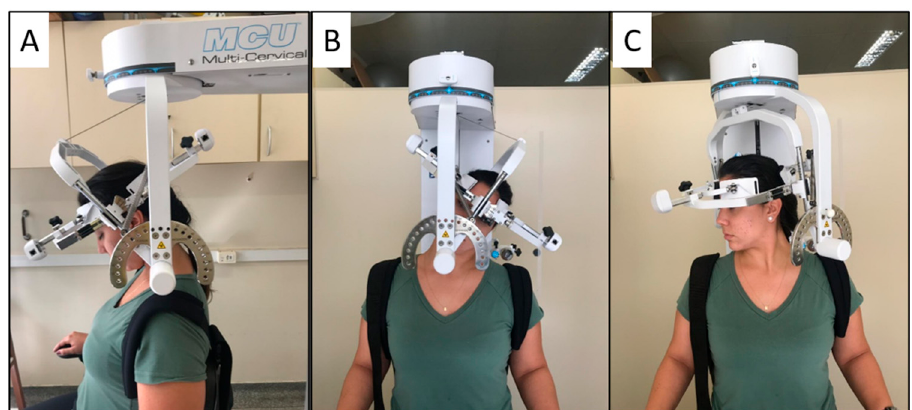
Figure 1. Illustration of the subject’s position in the Multi Cervical Rehabilitation Unit ® performing the cervical range of motion assessment on the sagittal plane ( A ), frontal plane ( B ), and transverse plane ( C ).